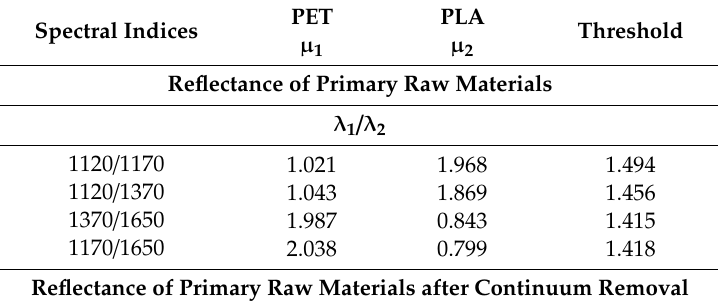
Table 4. First set of spectral indices for the pair PET-PLA. λ 1 / λ 2 ( λ 1 – λ 2 ) are computed as the ratio among reflectance values at wavelengths λ 1 and λ 2 .